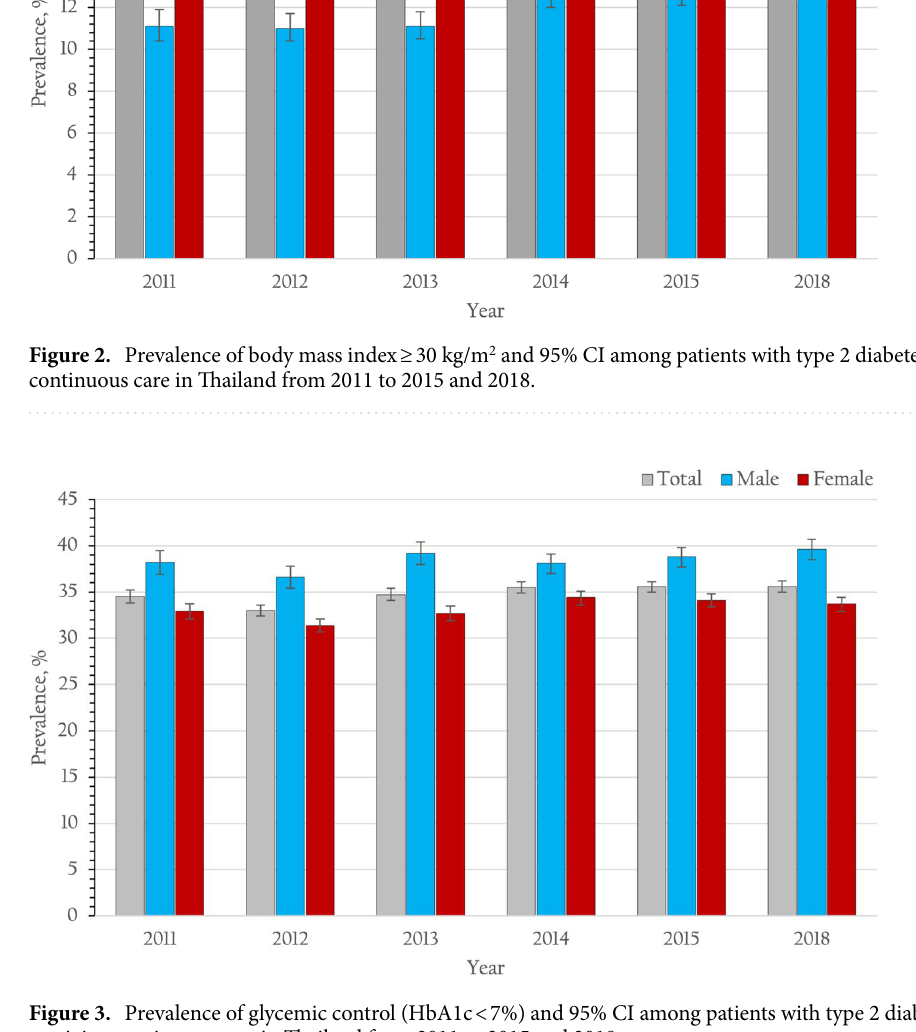
Figure 3. Prevalence of glycemic control (HbA1c < 7%) and 95% CI among patients with type 2 diabetes receiving continuous care in Thailand from 2011 to 2015 and